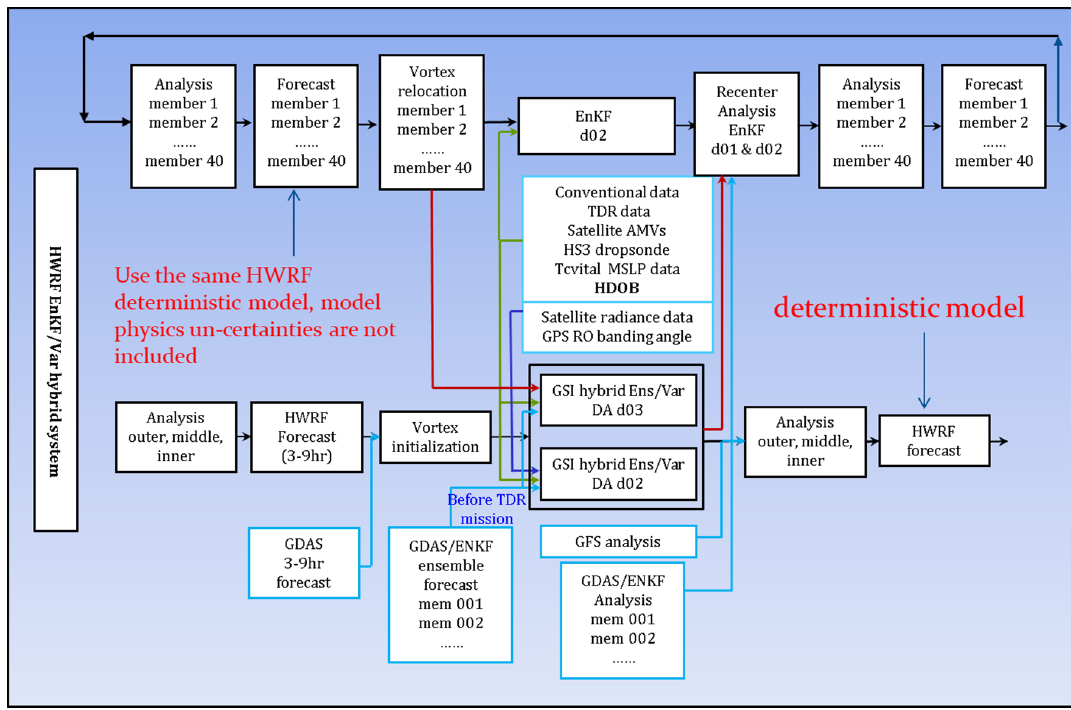
Figure 1. Schematic flowchart for the self-cycled Hurricane Weather and Research Forecasting (HWRF) data assimilation (DA) system. The d02 and d03 refer to the HWRF nested outer and inner domains, respectively. See acronym list.